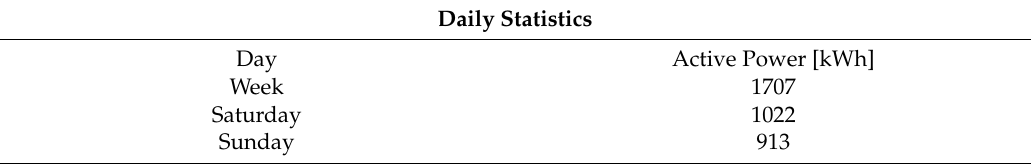
Table 5. Average daily statistics of the measurements performed in order to obtain load